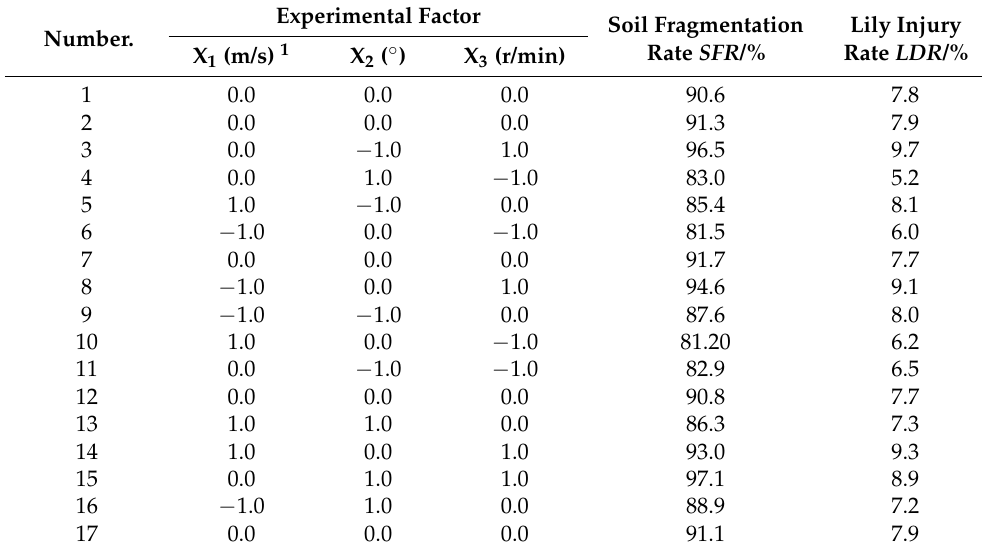
Table 3. Experiment scheme and